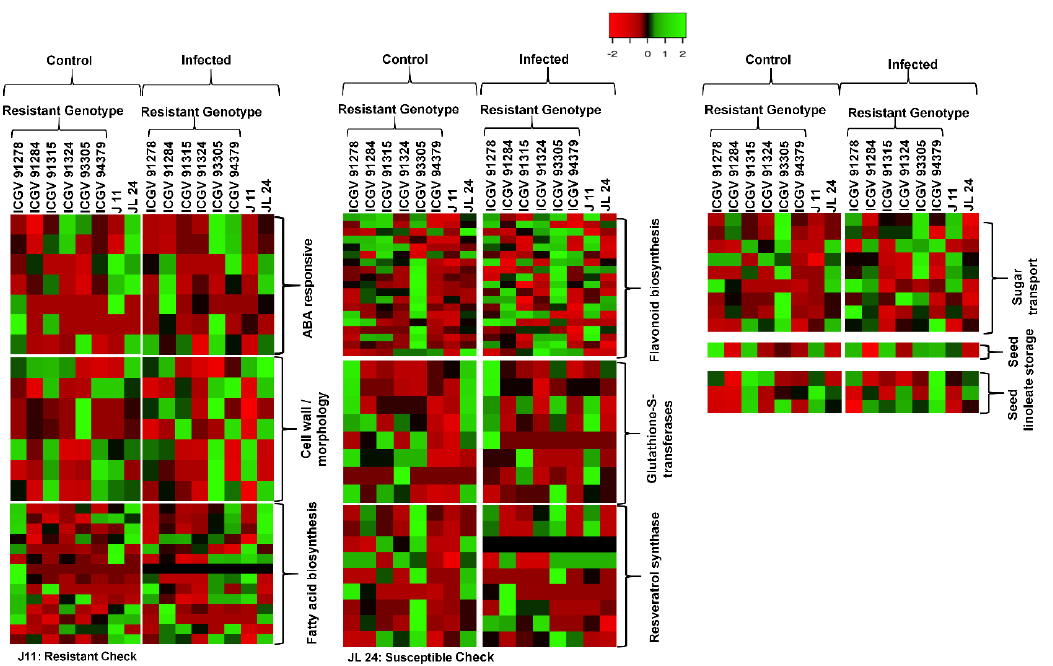
Figure 7. Heat map of different pathways of genes affected in 8 groundnut genotypes, both under control conditions and after infection with A. flavus. Some selected genes altered their expression in all of the pathways due to different pre-harvest aflatoxin contamination. Expression of genes involved in the glutathione-S-transferase, flavonoid biosynthesis, fatty acid biosynthesis, ABA responsive genes, resveratrol synthase, and seed linoleate gene expression is plotted. The color code corresponds to the FPKM value of the transcripts, increase from red to green. Genotype and treatment labels are shown at the top of the figure.